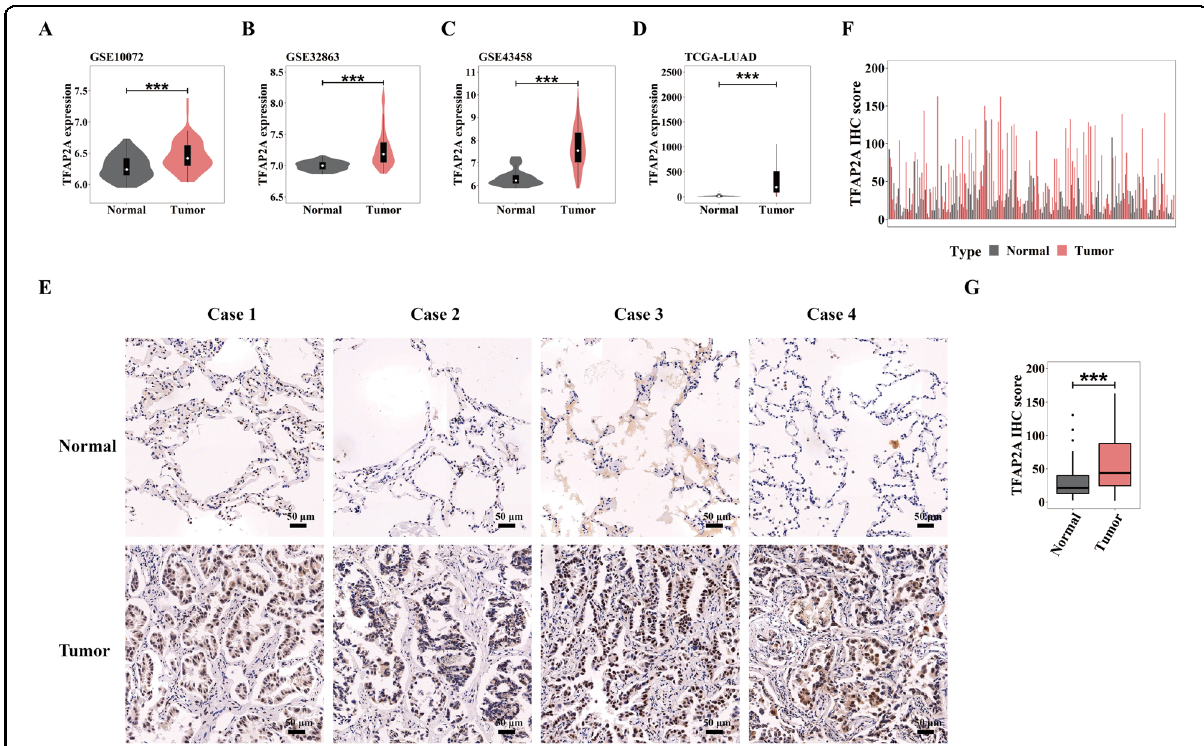
Fig. 1 TFAP2A shows high expression pro fi le in LUAD. A – D TFAP2A transcript levels between normal tissues and tumor tissues in LUAD datasets (GSE10072, GSE32863, GSE43458 and TCGA-LUAD). E IHC staining for TFAP2A protein levels in four paired normal tissues and tumor tissues in LUAD- TMA. F TFAP2A IHC scoring of 127 paired normal and tumor tissues in LUAD-TMA. G Statistical analysis of TFAP2A protein level (IHC scoring) in